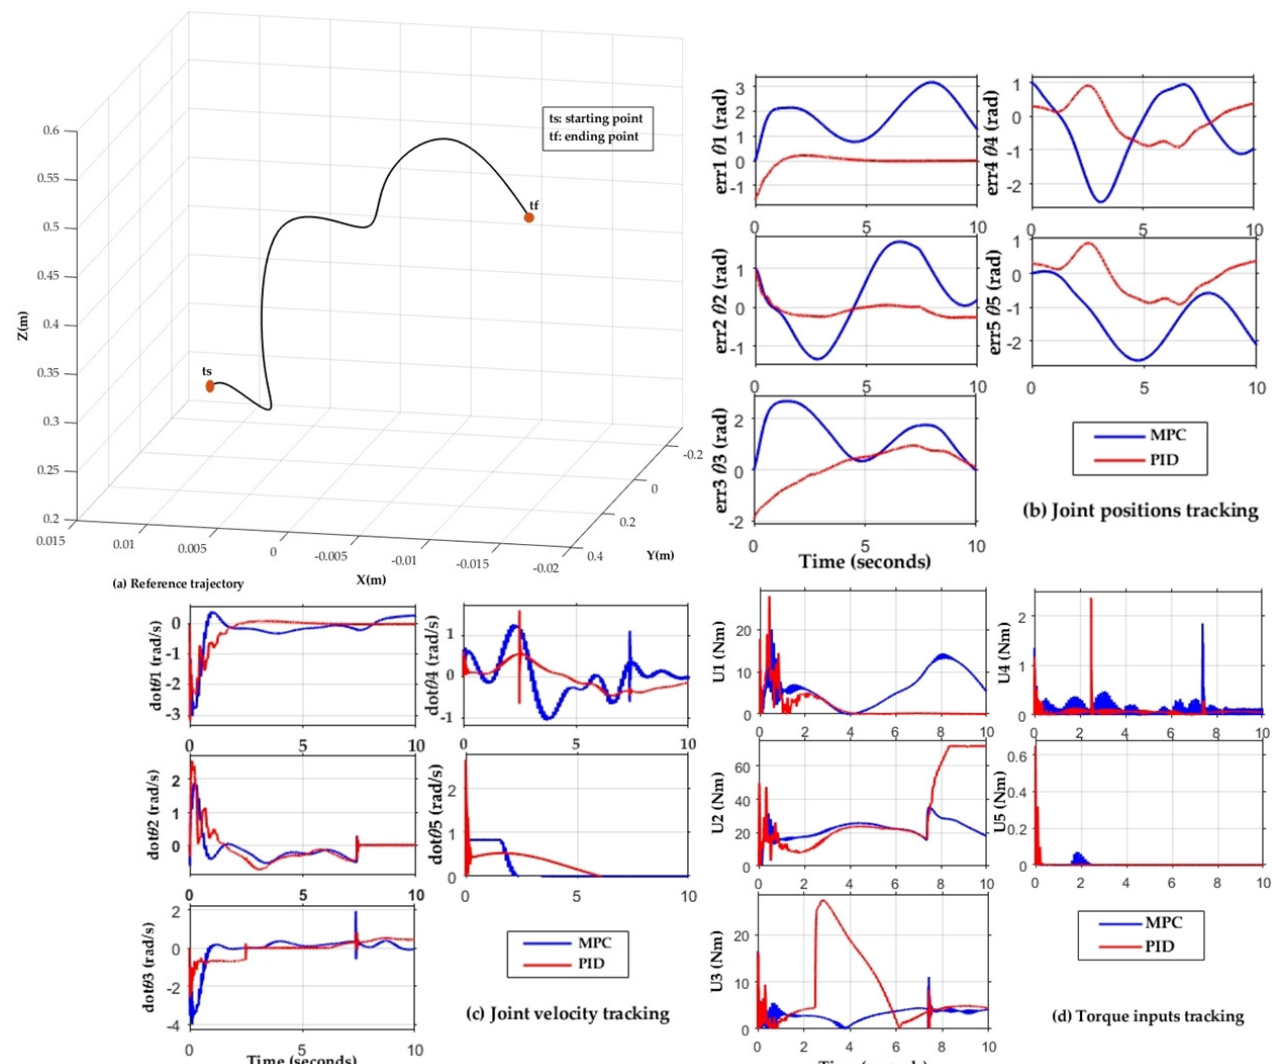
Figure 10. Simulation results relating to the semi-curve reference trajectory.